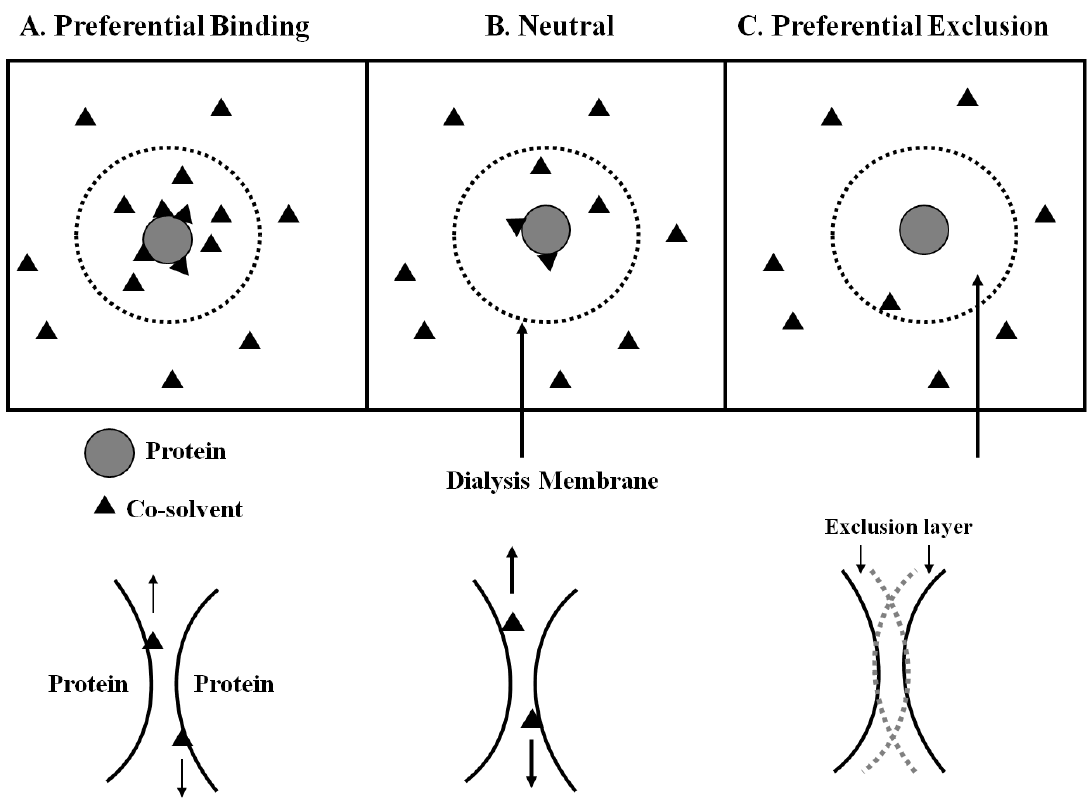
Figure 12. Different mode of interactions between co-solvent and protein. ( A ) denaturants. ( B ) arginine. ( C ) stabilizers. Upper panels show the interaction, while the lower panels show how protein–protein interaction affects co-solvent interaction at the protein–protein